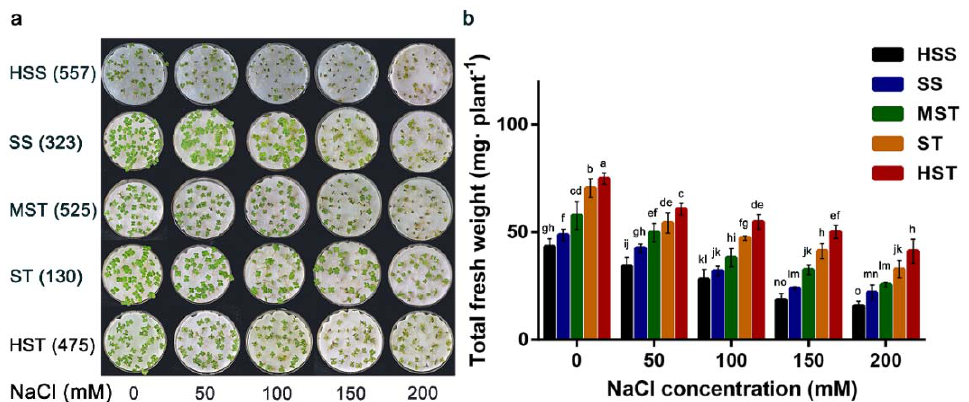
Figure 1. Seedling growth phenotypes of five B. napus lines at five salt tolerance levels. ( a ) Phenotypes of the seedlings with high salt sensitivity (HSS, 557); salt sensitivity (SS, 323); moderate salt tolerance (MST, 525); salt tolerance (ST, 130); and high salt tolerance (HST, 475) at different NaCl concentrations. ( b ) Average total fresh weight of the B. napus lines when grown at different NaCl concentrations. Error bars indicate standard deviation ( n = 4). Statistical significance was determined using a one-way ANOVA and Duncan’s multiple range test. Significant differences at p < 0.05 are represented by different letters above the bars. 557, 323, 525, 130, and 475, these numbers represent the number of the B. napus lines.